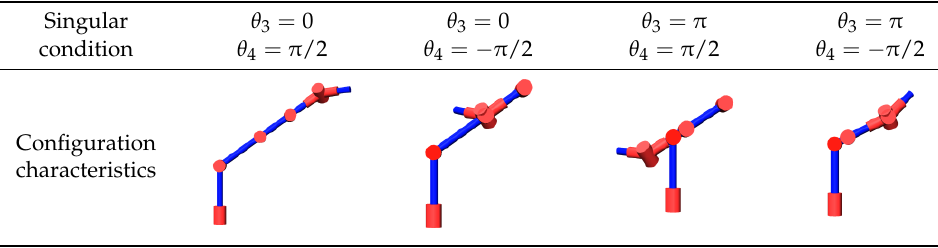
Table 5. Singularities corresponding to condition 4.